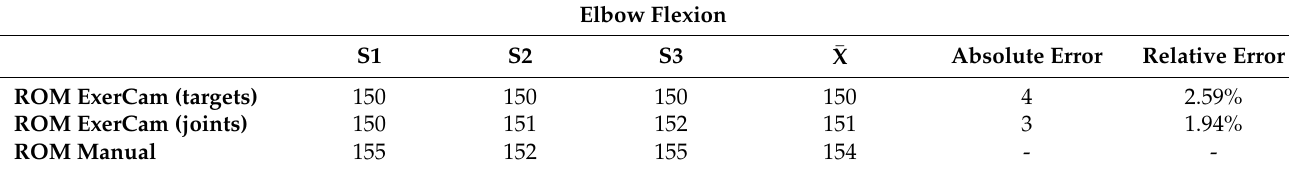
Table 4. Results of the measurements in the elbow flexion task.